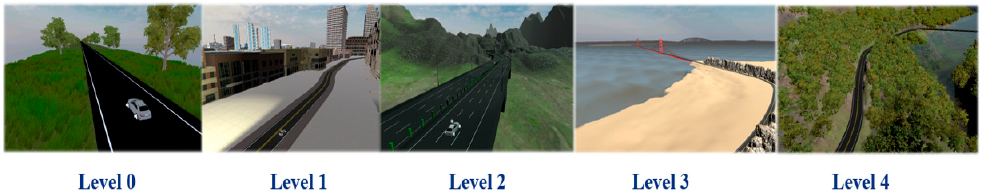
Figure 3. Sample road conditions for levels 0~4 scenario designs.